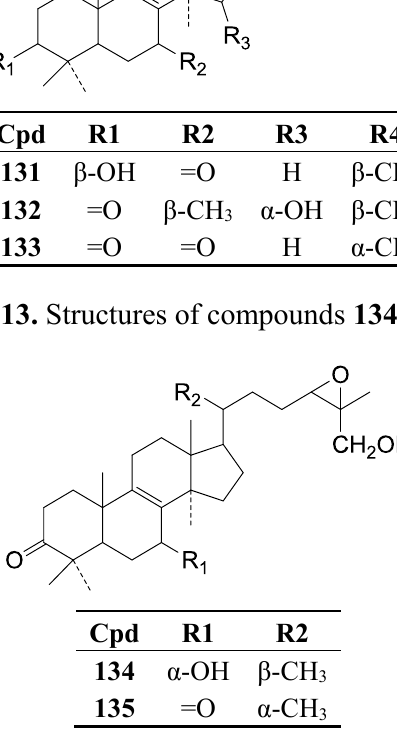
Figure 14. Structures of compounds 136 ‒ 139